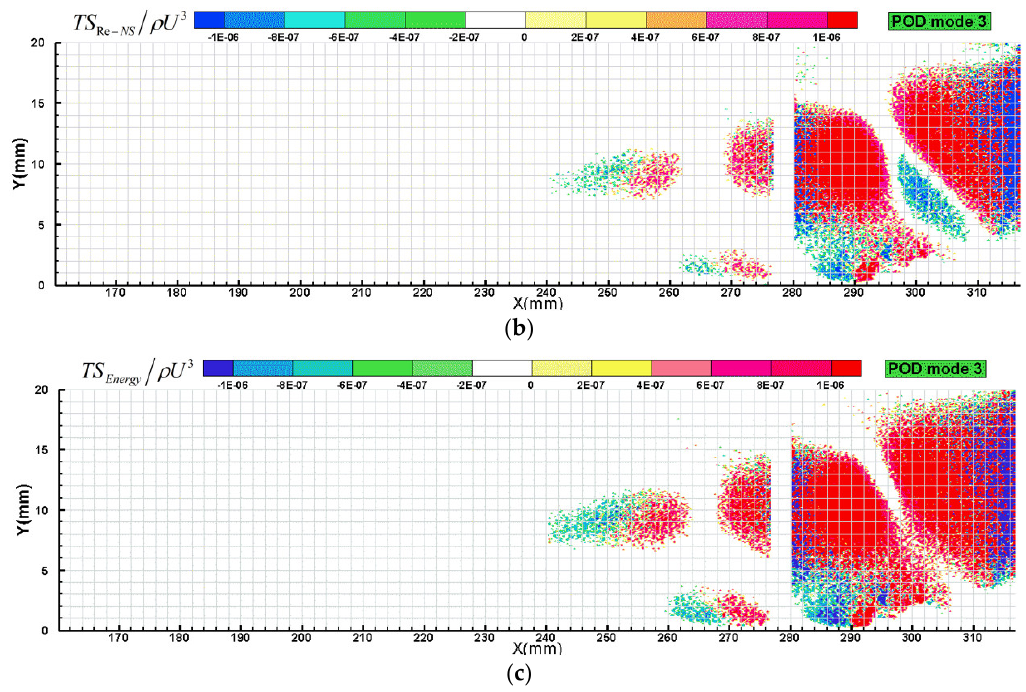
Figure 16. Entropy generation of third order mode: ( a ) the Reynolds sheer stress term; ( b ) the Reynolds normal stress term; and ( c ) the energy flux